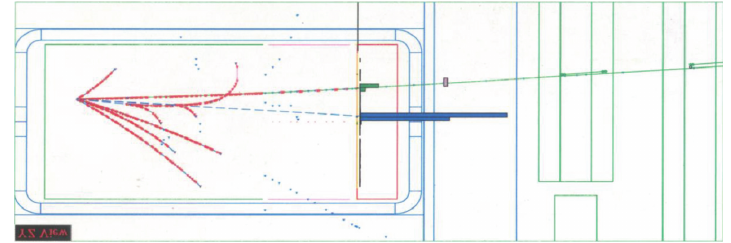
Figure 5: Candidate ] 𝜇 CC event reconstructed in the NOMAD detector.